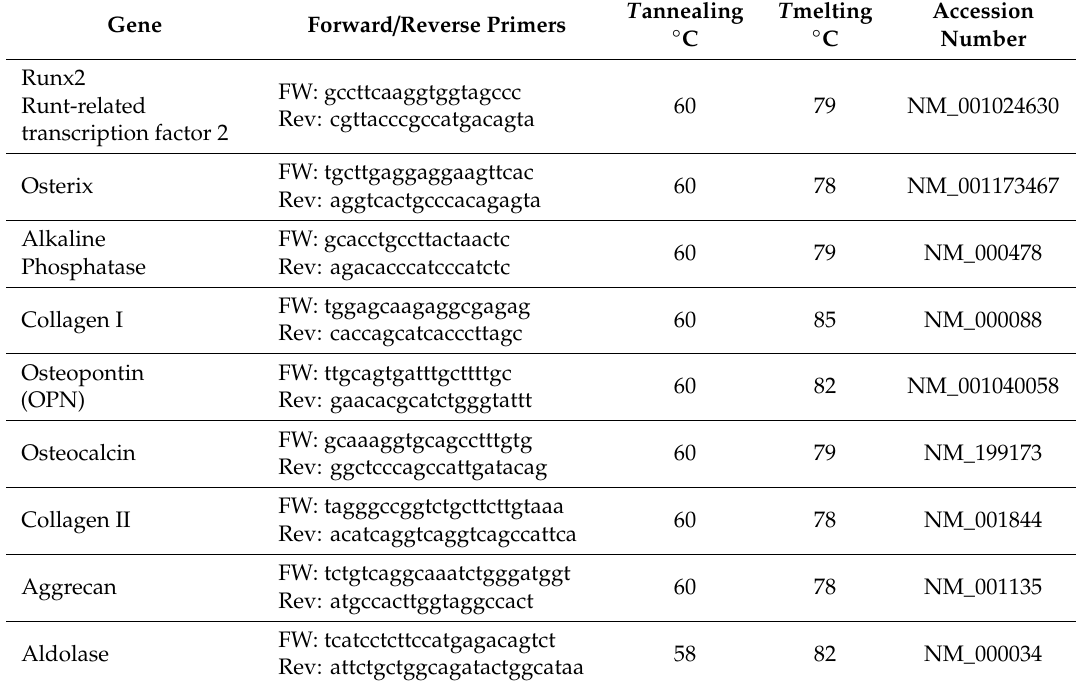
Table 1. Primer sequences, annealing ( T annealing ) and melting ( T melting ) temperatures, and